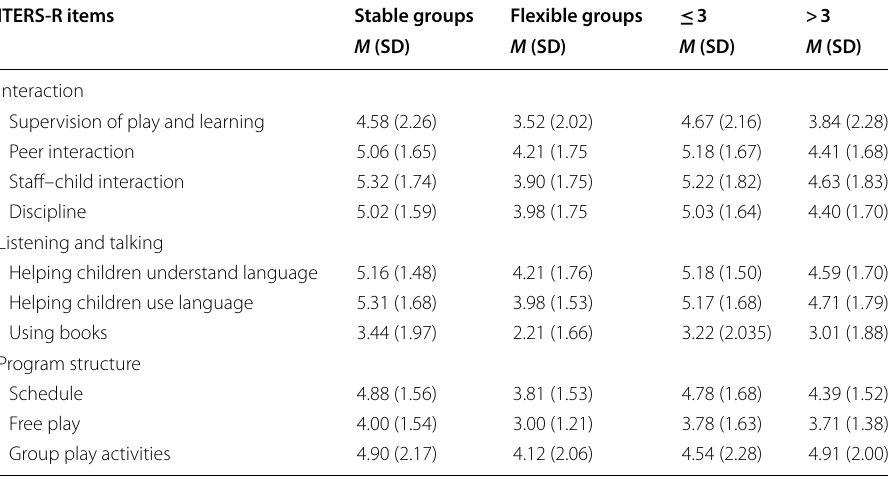
3 equal to or less than three children per staff; > 3 ≤ =